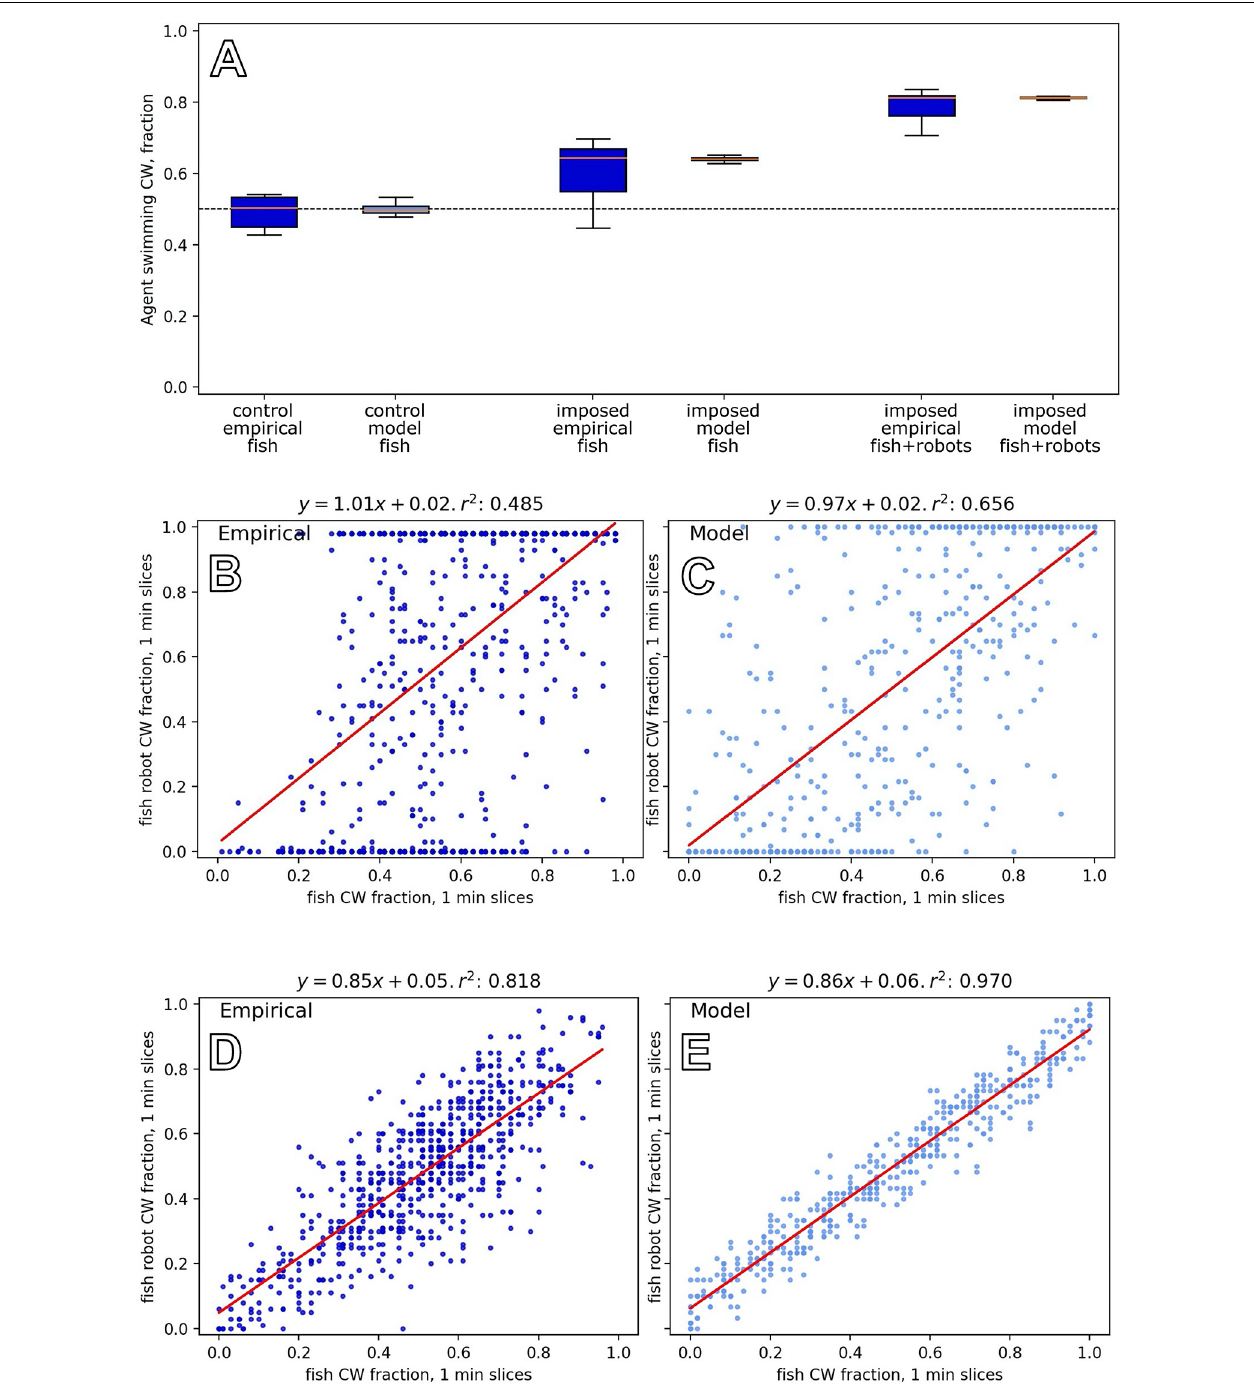
FIGURE 10 | Results of model and empirical data from experiments with robots and fish groups, experiments F1–F3. (A) Comparing group-level direction choices between six fish (left) and a mixed group of three fish with three robots that constantly swam in the same direction (the right shows the whole group, and the middle shows data for the three fish in the context of robots). Trends in the empirical data, from N = 8 repetitions (Bonnet et al., 2018) are reflected in the model output. (B) Experiments with five fish and one fish robot that had an exogenously defined motion, switching direction in 1.4% of the time steps, reveals a correlation between the swimming direction of the fish group and the robot (empirical data from Bonnet et al., 2019 with N = 24 repetitions). (D) Experiments with five fish and one fish robot that acted to reinforce the swimming direction of the fish group (empirical data from Bonnet et al., 2019, with N = 22 repetitions). The relationship between the fish robot direction and fish group decision is tighter in this closed-loop setting than in the open-loop setting above. (C,E) Equivalent output from our model for experiments F2 and F3, showing the same trends as the empirical results.